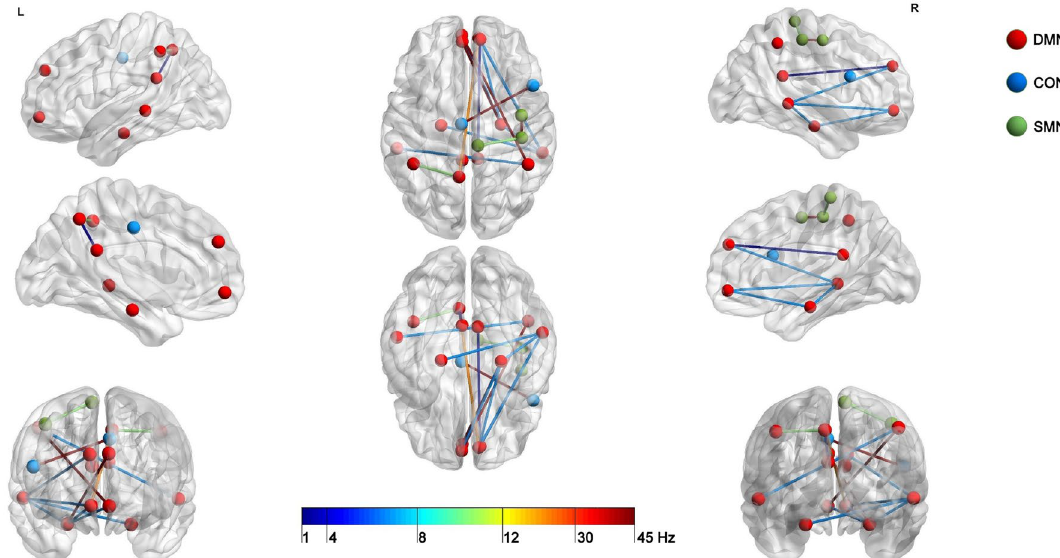
Figure 3. Schematic localization of nodes and intra-network functional connections, which measures significantly differentiated groups categorized on the basis of dispositional Mind Wandering. Nodes are indicated as balls and connections as lines. Red nodes belong to DMN, blue to CON, and green to SMN. According to added scale, line colors represent frequency bands. Dark and light blue lines indicate connections in delta and theta bands, light green alpha, yellow beta and red gamma bands.